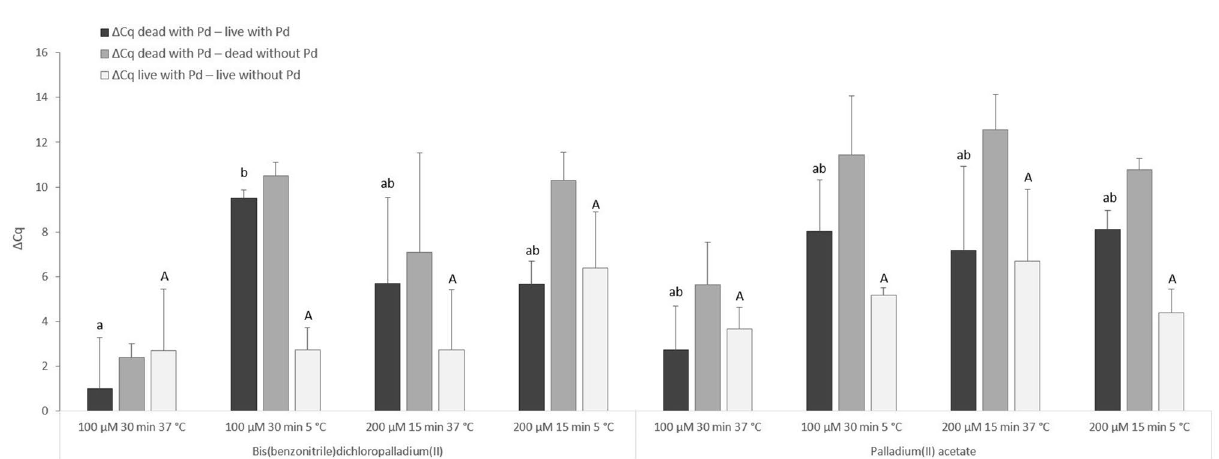
Figure 3. The effect of treatment of M. smegmatis cells with bis(benzonitrile)dichloropalladium(II) and palladium(II)acetate at two different concentrations (100 µM, 200 µM), times (30 min, 15 min) and temperatures (37 °C, 5 °C). The ΔCq values represent the individual mean differences of Cq values counted from four biological and technical replicates. One-way ANOVA and Tukey´s HSD test were used to evaluate the significance of differences between ΔCq. Identical letters signify statistically insignificant differences (P > 0.05) between ΔCq values, and different letters signify significant differences (P < 0.05). The values of ΔCq dead with Pd – live with Pd were labeled with lowercase letters, and the values of ΔCq live with Pd – live without Pd were labeled with capital letters, since they were assessed separately. Error bars express standard deviations counted from four